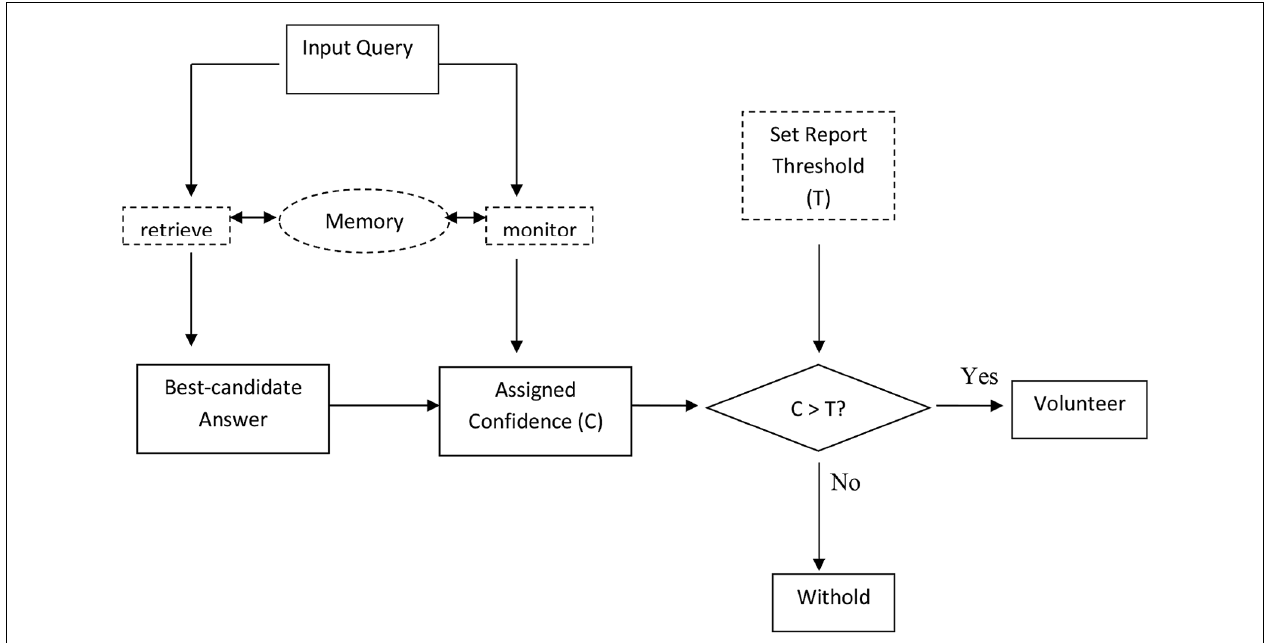
process of setting a response threshold might mediate the impact of distraction. Note that if distraction lowers confidence in an output, then this will have the same negative effect on volunteering the item as raising the report threshold for that